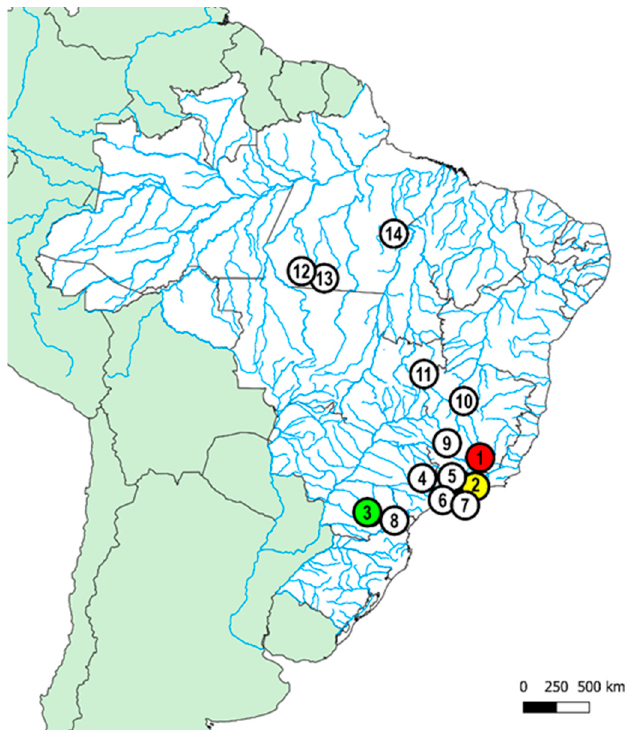
Figure 1. Partial map of South America highlighting the Brazilian collection sites of the three Harttia species analyzed in the present work (color circles) named: 1. H. intermontana (red circle); 2. Harttia sp. 1 (yellow circle); and 3. Harttia sp. 2 (green circle). The white circles represent other Harttia species previously studied: 4. H. absaberi , 5. H. carvalhoi , 6. H. gracilis , 7. H. loricariformis , 8. H. kronei , 9. H.